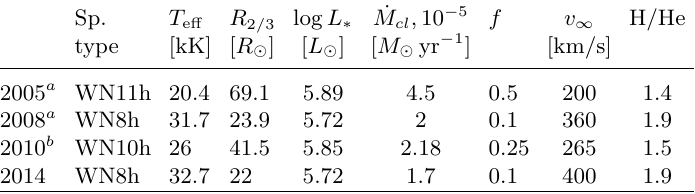
Table 1. Derived properties of V532. H/He denotes hydrogen number fraction relative to helium, f is the filling factor. Sp. T eff R 2 / 3 log L ∗ ˙ M cl , 10 − 5 f v ∞ H/He